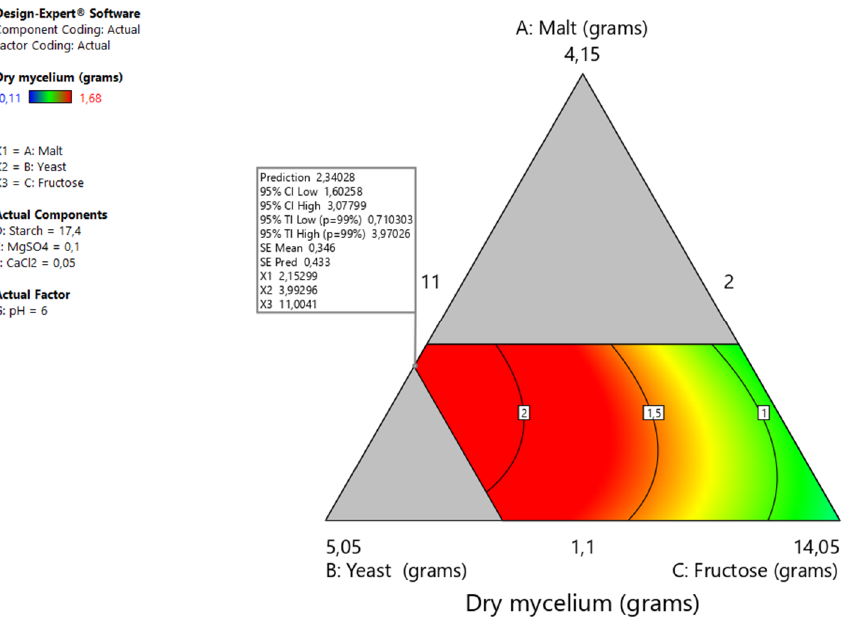
Figure 4. Contour plot of the modeled effect of broth components (g/500 mL) and interactions on I. obliquus dry mycelium weight.